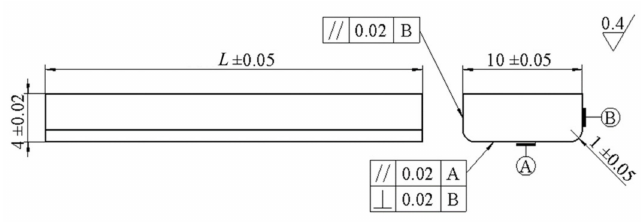
Figure 4. Design drawing of three-point bending specimen.